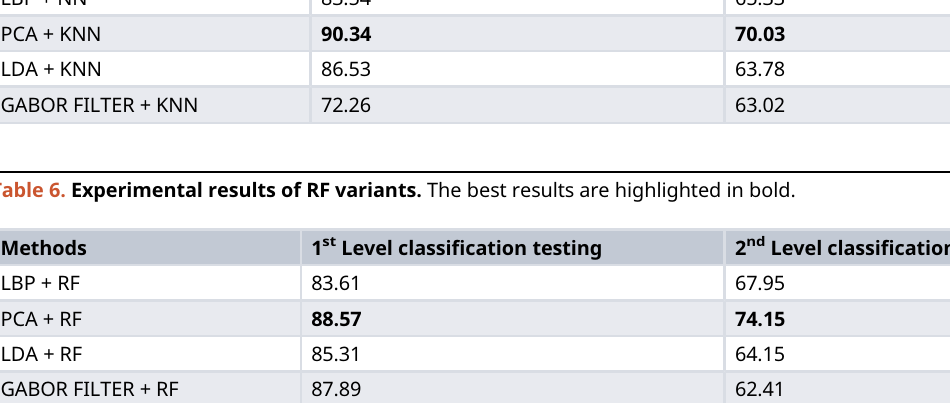
Table 5. Experimental results of KNN variants. The best results are highlighted in bold. Methods